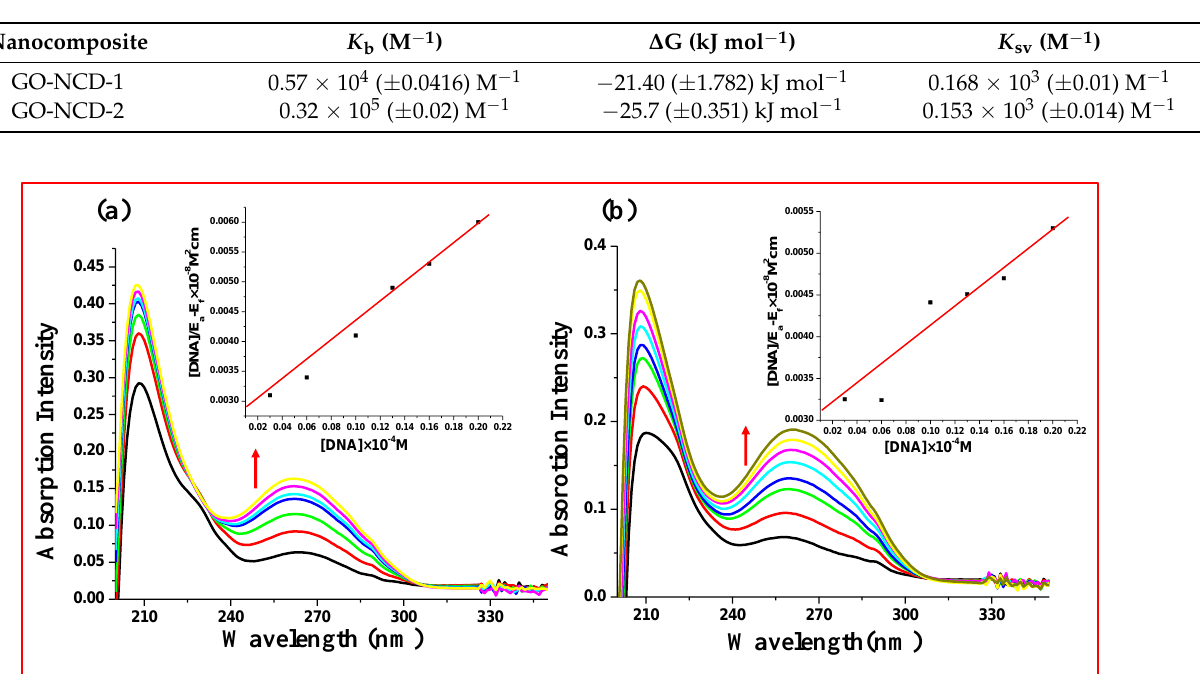
Figure 7. UV-visible spectra of ( a ) GO-NCD- 1 and ( b ) GO-NCD- 2. Table 1. Calculated K b and K sv values of GO-NCD- 1 and GO-NCD- 2.